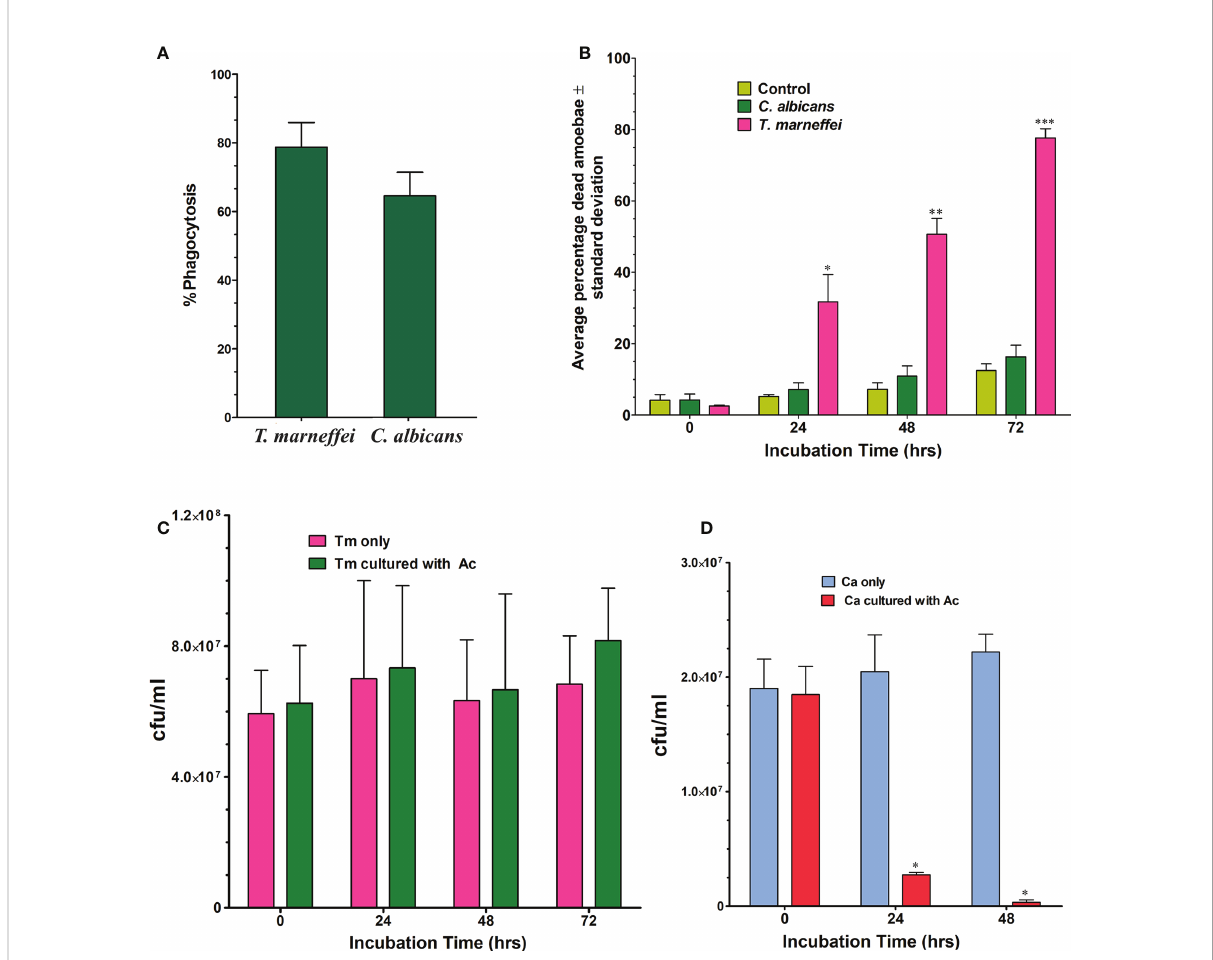
FIGURE 2 Phagocytosis of T. marneffei (Tm) and C. albicans (Ca) by the A. castellanii (Ac). (A) The percentage of phagocytosis was determined by counting the total number of A . castellanii with internalized conidia or yeast cells per 100 (A) castellanii cells after 2 h of co-incubation. The bars represent the mean and SD from three independent experiments. (B) Average percentage of dead amoebae ( A. castellanii ) after co-incubation with C. albicans or T . marneffei at different time points, 0, 24, 48 and 72 h Amoebae incubated in PBS alone was included in the experiment as negative control. When T. marneffei was compared to C. albicans , there was a signi fi cant difference at 24, 48, and 72 hours. * p = 0.0002 at 24 h, ** p = 0.0002 at 48 h and *** p = 0.0001 at 72 h (C) T. marneffei viability in the absence or in the presence of amoebae at 37°C. There was no signi fi cant statistical difference. (D) C. albicans viability in the absence or in the presence of amoebae at 37°C. There are signi fi cant differences in C . albicans co-incubated with amoebae compared to the control (in PBS). ( *p <